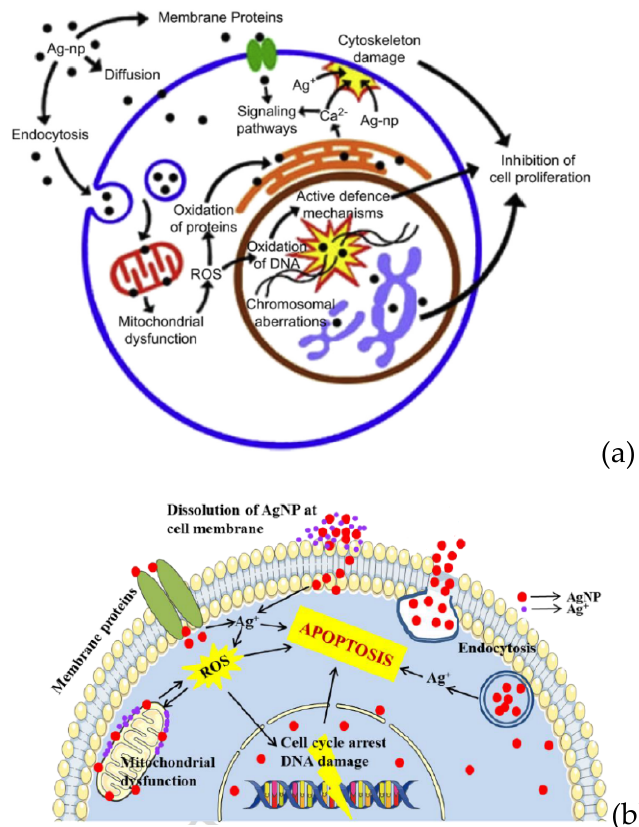
Proposed mechanisms of ( a ) AgNPs- and ( b ) silver ion-induced cytotoxicity. Reproduced from [190] and [192] with permission of BioMed Central Ltd and Elsevier, respectively.